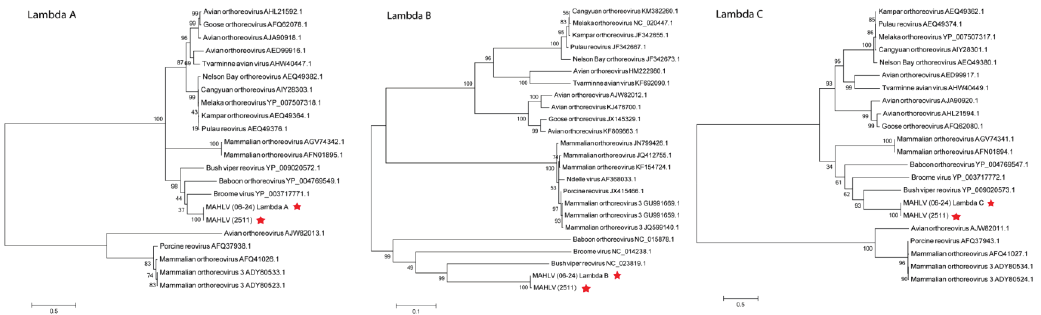
Figure 8. Molecular phylogenetic analysis by Maximum Likelihood method showing the placement of MAHLV within the Orthoreovirus genus using amino acid sequences of the ORFs in the three large segments, L1, 3 and 2 coding for proteins Lambda A, B and C.